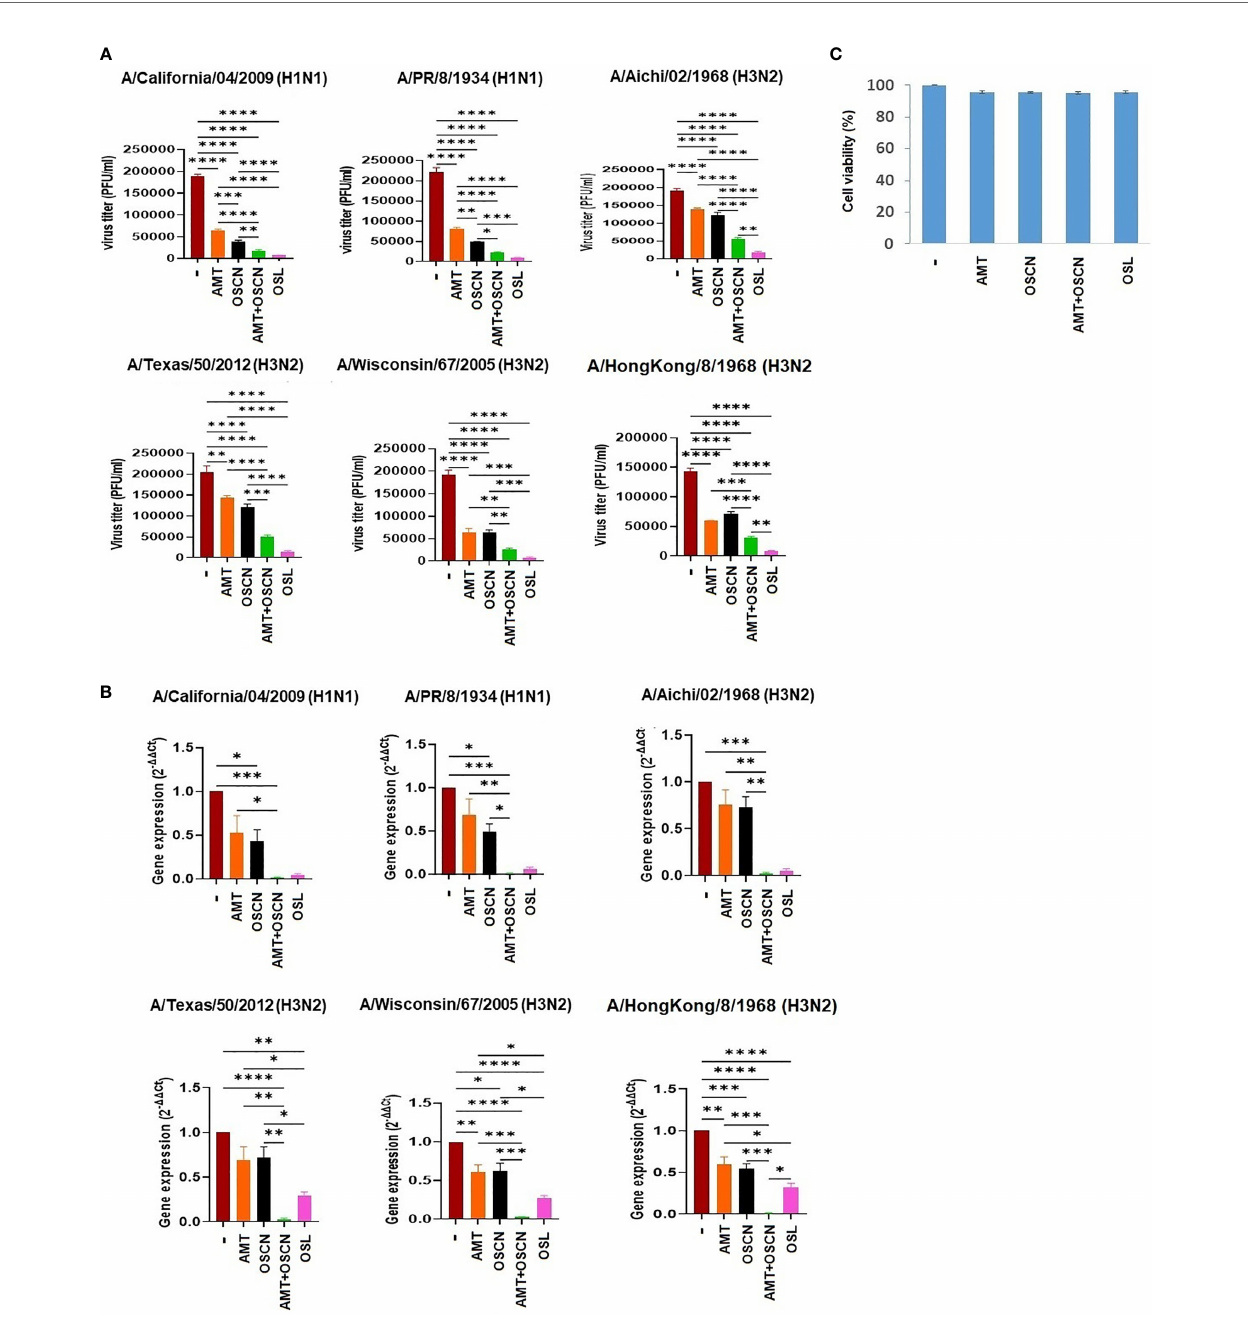
FIGURE 1 | The AMT+OSCN − combination treatment signi fi cantly reduces the replication of several in fl uenza A virus strains in vitro . (A) Con fl uent monolayers of MDCK cells were inoculated with 100 MOI of the indicated six H1N1 and H3N2 IAV strains individually. The overlay media were supplemented with the indicated antiviral compounds. Viral proliferation was measured by PFU assay. OSL phosphate was used as a control. Data are mean ± SEM of n = 6 (A/California/04/2009, A/PR/8/34, and A/Aichi/2/1968), n = 4 (A/Texas/50/12 and A/Hong Kong/8/68), and n = 5 (A/Wisconsin/67/2005) independent experiments. One-way ANOVA and Tukey ’ s multiple comparisons tests. (B) Viral mRNA levels were measured under the exact same conditions and at the same time as in panel (A) by qRT-PCR for the indicated viral strains. All shown results were normalized and compared to housekeeping genes as control. OSL was used as positive control. Mean ± SEM, n = 3. One-way ANOVA and Tukey ’ s multiple comparisons test. (C) MDCK cells were exposed to the indicated treatment options without viral infection, and cell toxicity was measured by the MTT Cell Proliferation Kit (colorimetric assay). At 3 days after drug addition, the treatment was added at maximum dose: OSL at 5 m g/ml and AMT at 15 m g/ml. Untreated but infected cells were used as positive control for cell toxicity, while uninfected, untreated cells were used as negative control (n = 3). AMT, amantadine; MOI, multiplicity of infection; OSCN − , hypothiocyanite; OSL, oseltamivir; PFU, plaque-forming unit; MDCK, Madin – Darby canine kidney; IAV, in fl uenza A virus.*, p < 0.05; **, p < 0.01; ***, p < 0.001; ****, p <